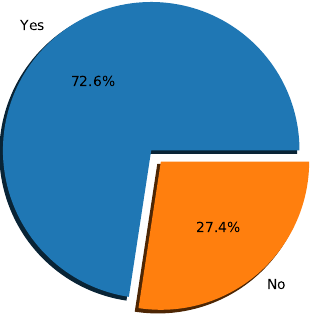
Figure 19. Patients’ opinion about future reuse of the